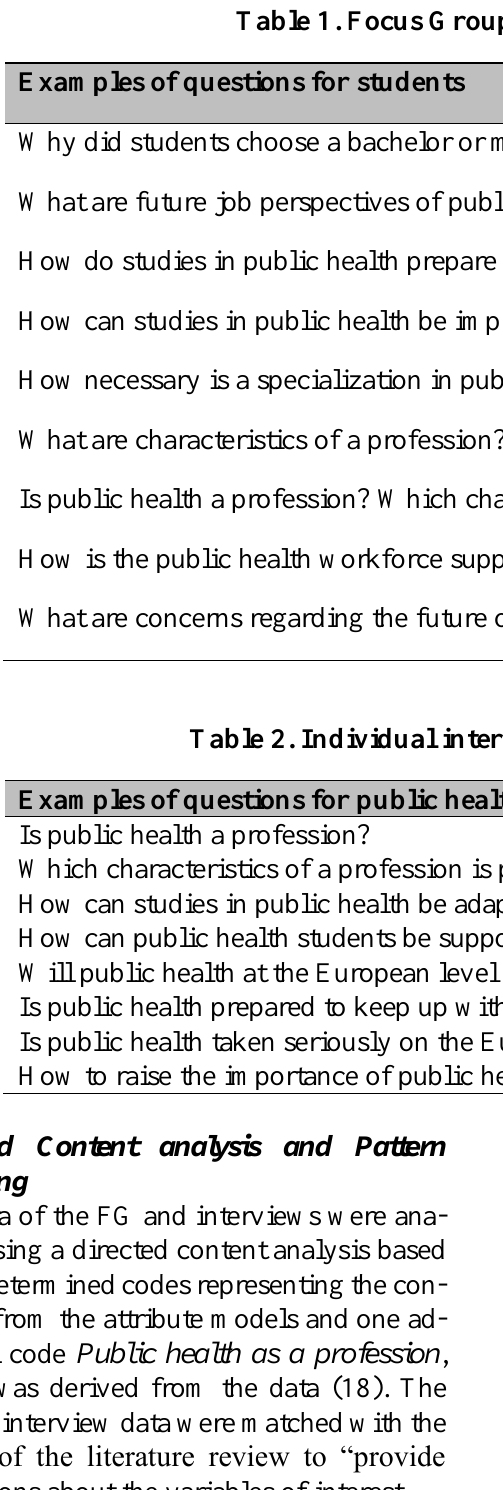
Table 1. Focus Group guiding questions